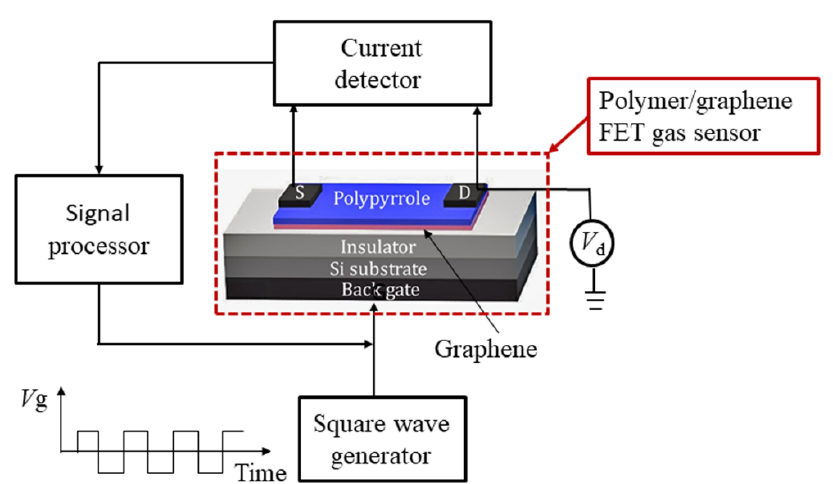
Figure 3. Overview of the proposed measurement methodology: a square wave generator outputs a square wave voltage to the back gate of the FET sensor so as to modify the response and recovery of the sensor when the sensor is exposed to a target gas. A current detector is electrically connected between the source and drain of the sensor to detect current changes and to provide feedback current modulations to a signal processor when the target gas is on/off. The signal processor is configured to communicate the information between the square wave generator and the current detector.